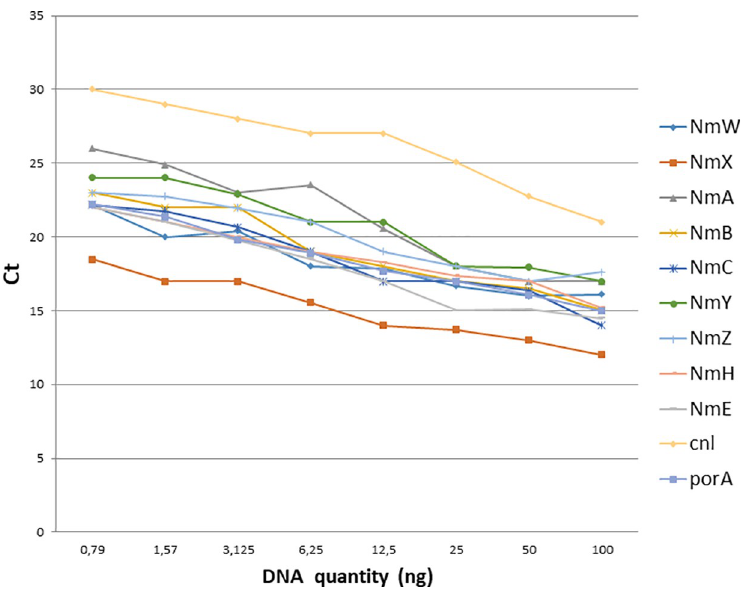
Fig 2. qPCR standard curves. Eight two-fold dilutions of DNA from each positive control were performed and tested in a qPCR assay with appropriate primers and probes. The Ct observed for each dilution is plotted against the DNA concentration demonstrating a decrease in Ct with increased DNA concentration and detection for all genogroups with a threshold of 30. sodC was empirically tested later and demonstrated the same threshold (data not